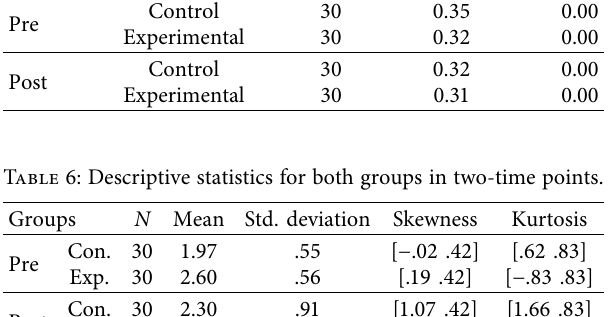
Table 5: Kolmogorov–Smirnov test of normality. Groups